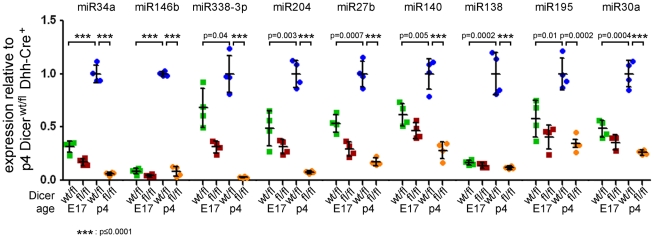
Real time PCR confirmation of miRNAs upregulated upon myelination.Expression of miRNAs in sciatic nerves of E17 and p4 Dicerfl/fl Dhh-Cre+ (fl/fl) and control Dicerwt/fl Dhh-Cre+ (wt/fl) mice was analyzed by real time PCR with Taqman probes. The levels of miRNA expression were quantified in comparison with sno234 RNA as the endogenous control. Expression is shown as relative values compared to p4 Dicerwt/fl Dhh-Cre+. Error bars indicate standard deviation. All miRNAs analyzed were significantly downregulated in Dicerfl/fl Dhh-Cre+ nerves at p4: p≤0.0001 (miR-34a, miR-146b, miR-338-3p, miR-204, miR-27b, miR-140, miR-138, miR-30a), p = 0.0002 (miR-195). Furthermore, miRNAs were confirmed to be upregulated upon myelination: p≤0.0001 (miR-34a, miR-146b), p = 0.04 (miR-338-3p), p = 0.003 (miR-204), p = 0.0007 (miR-27b), p = 0.005 (miR-140), p = 0.0002 (miR-138), p = 0.01 (miR-195), p = 0.0004 (miR-30a). P values were determined using unpaired two-tailed student's t-test.